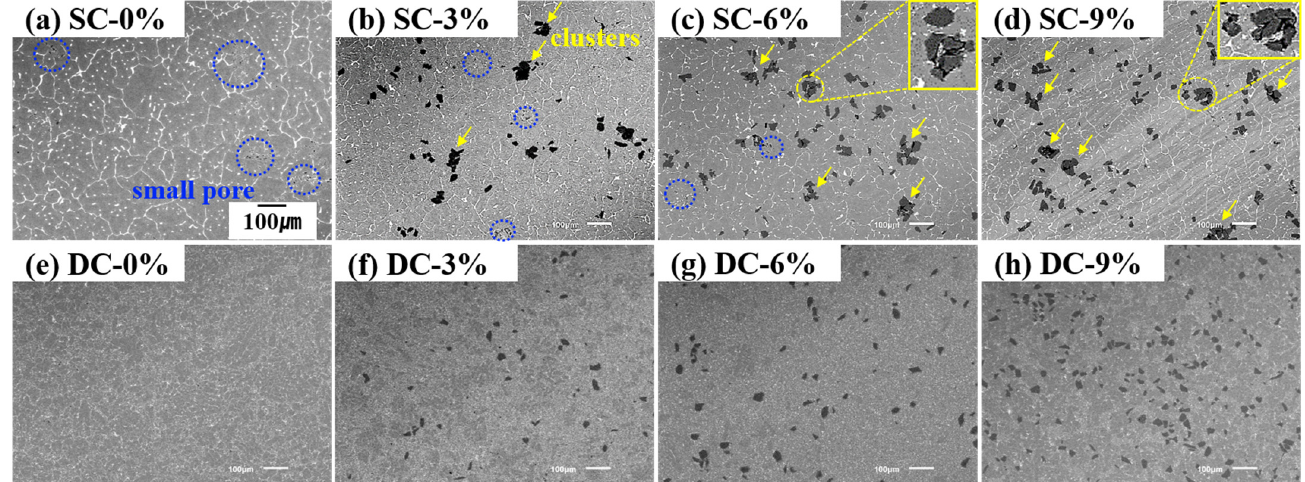
Figure 1. Microstructure of AA2024 alloy and aluminum matrix composites (AMCs) formed by the stir-casting (SC) process: ( a ) AA2024, ( b ) 3 vol.%, ( c ) 6 vol.%, ( d ) 9 vol.%, and after the die-casting (DC) process, ( e ) AA2024, ( f ) 3 vol.%, ( g ) 6 vol.%, ( h ) 9 vol.% (same magnification).